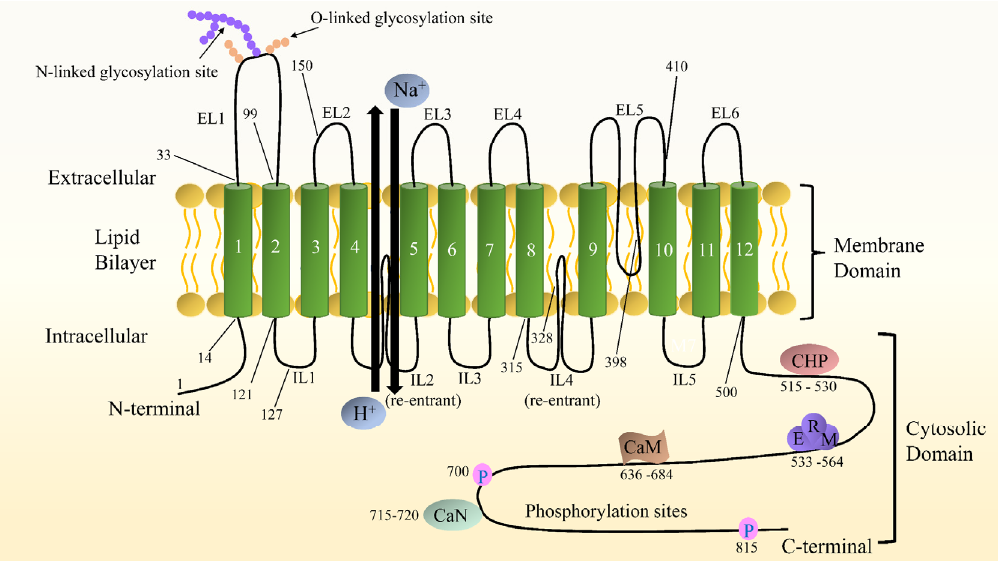
Figure 1. Schematic diagram of NHE1 topological structure. Both the N- and C- termini are located in the cytoplasm. The numbers indicate predicted transmembrane domains. Some representative amino acids are pointed out. The C-terminal hydrophilic cytoplasmic structural domain contains binding sites for a variety of proteins, including calmodulin (CaM), calcineurin (CaN), calcineurin homologous protein (CHP), and esrin/radixin/moesin (ERM), as well as cytoplasmic structural domains involved in phosphorylation and activity regulation.